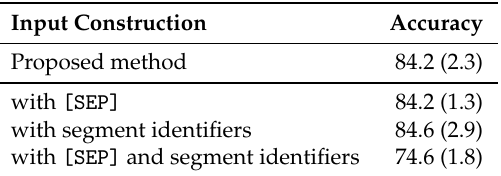
Table 4. Accuracy results (%) on the holdout set for different input construction methods. For each method, we performed five runs of fine-tuning with different random seeds, and the average accuracy is reported with the standard deviation in parentheses.